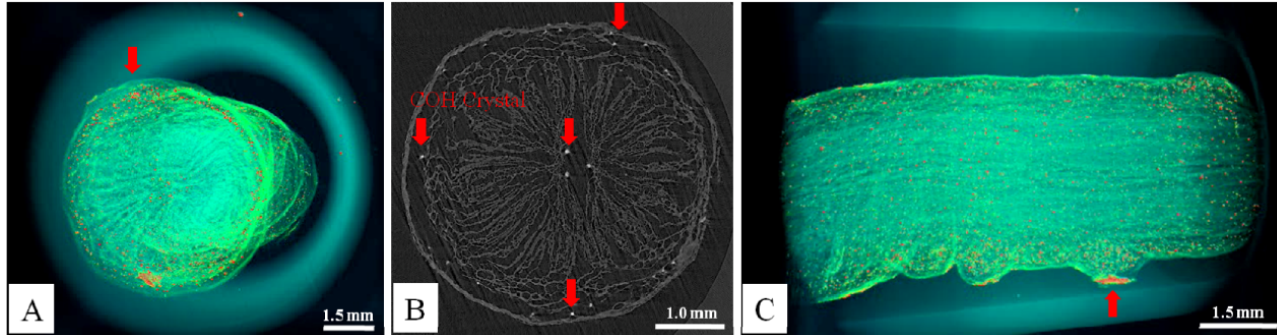
Figure 3. Small-angle X-ray scattering (SAXS) was used for the tomographic 3D reconstruction of dried ginseng samples (the red arrow points to the preferred position of COH Crystals aggregation in the taproot of ginseng). ( A ) One of the 3D rendering angles of ginseng taproot for counting COH Crystals; ( B ) the original cross section of tomography; ( C ) the other one of the 3D rendering angles of ginseng taproot for counting COH